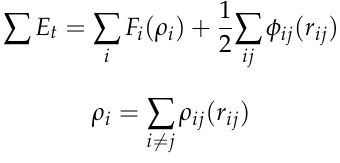
Table 1. Modeling parameters used in the simulations.